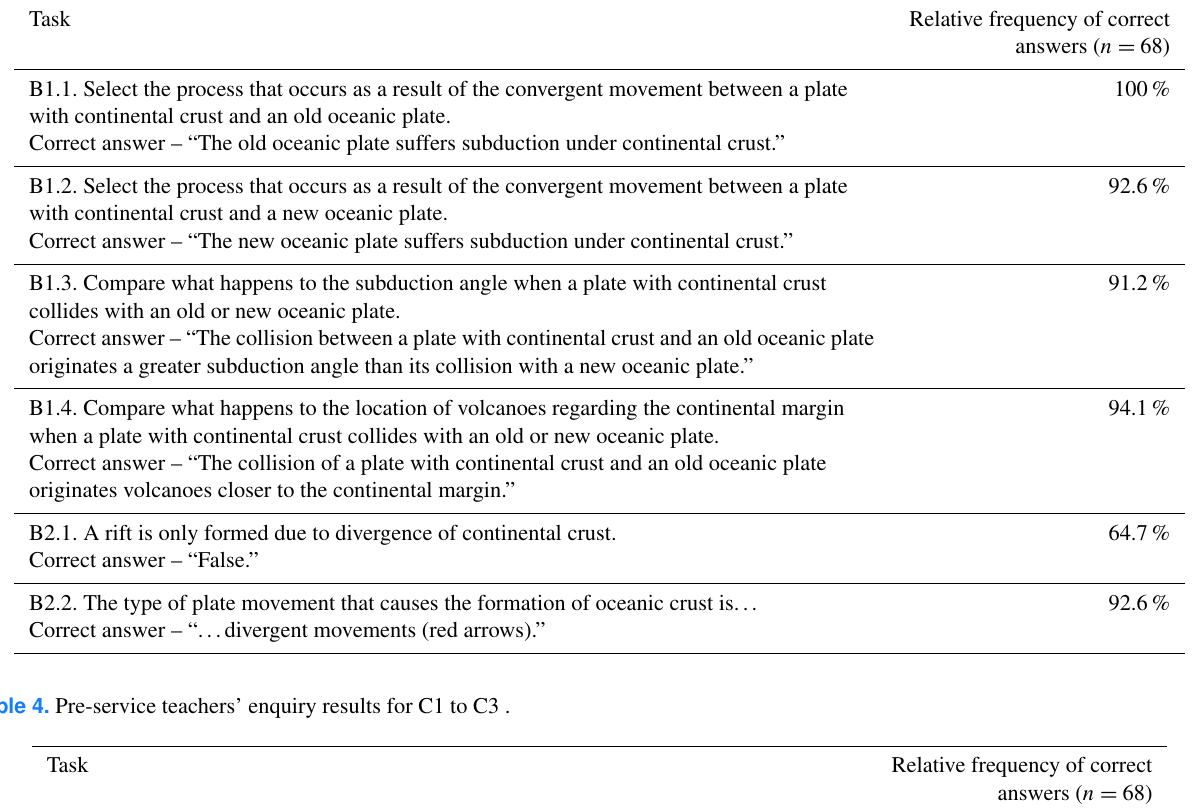
Table 3. Pre-service teachers’ results for B1.1. to B2.2. tasks. Task